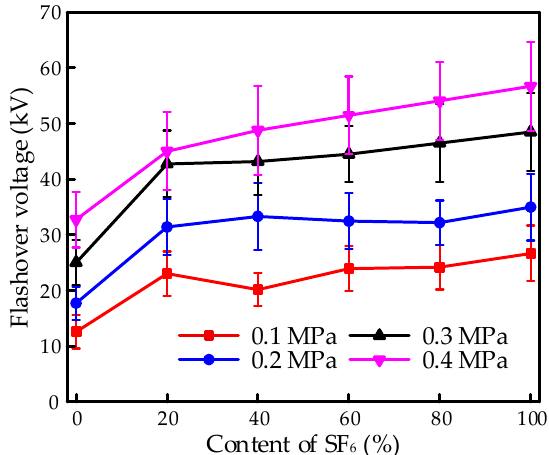
Figure 5. Relation between the flashover voltage and the content of SF 6 with various pressures under the needle-plate electrode system.